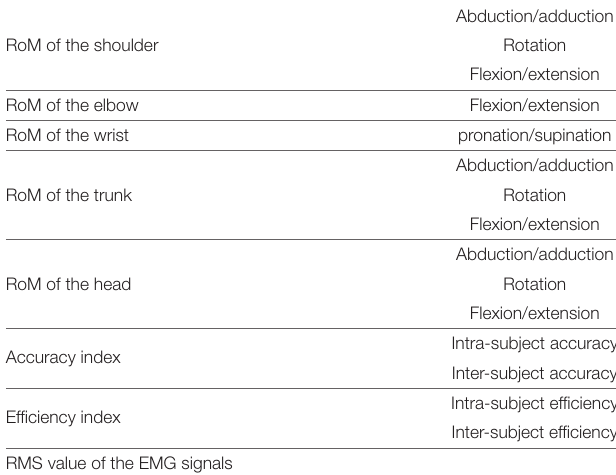
TABLE 1 | Variables calculated to evaluate the compensatory movement performed by the